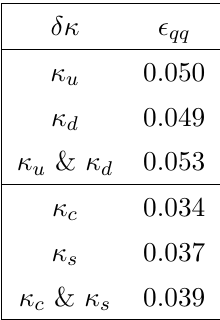
Table 3 . The dependence of (cid:15) qq on the (cid:13)avour of the Yukawa couplings’ scalings.